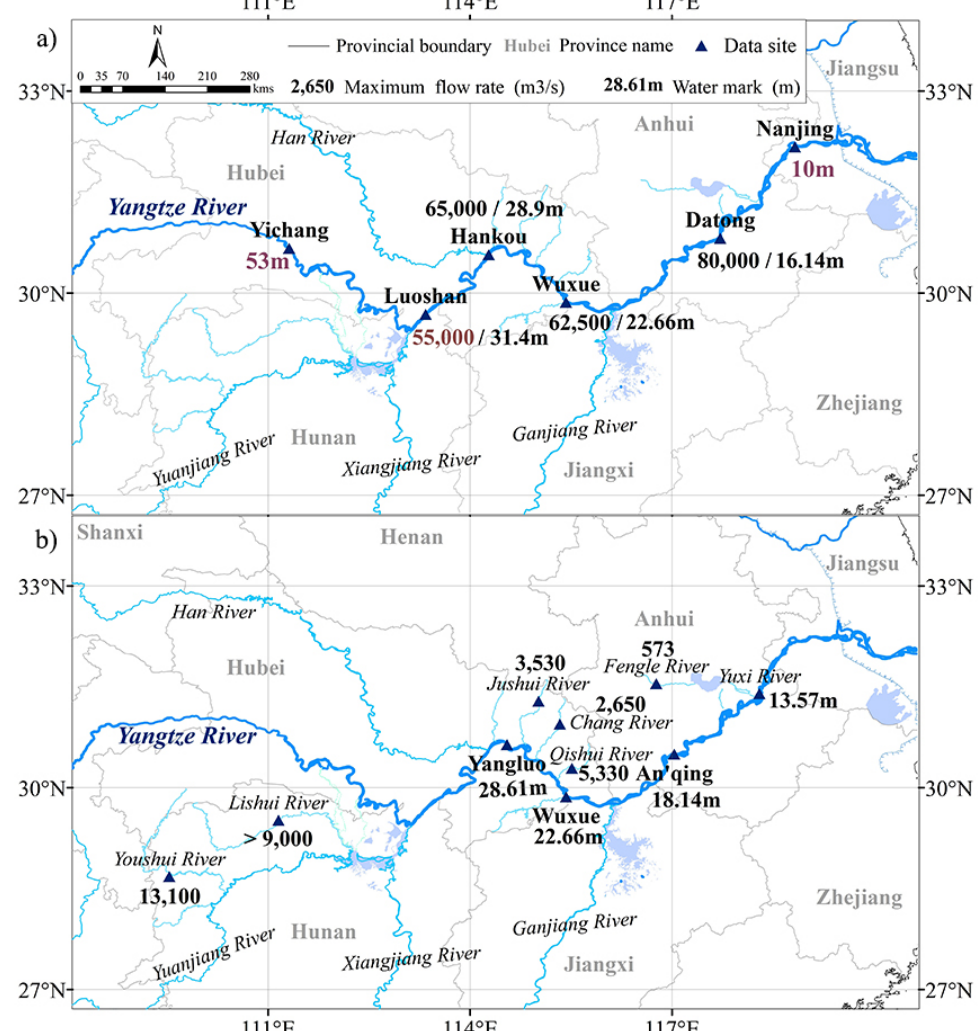
Figure 3. Flood peak flow rates and water levels of the Yangtze River in 1849. ( a ) shows the peak flow rates and water levels of the stations along the mainstream of the Yangtze River in 1849. Numbers such as “65,000” are the peak discharges of the year (m 3 /s), and numbers marked with “m” are the highest water levels of the year (relative to the base level at Wusong). The peak flow rate in black font is obtained by combining the peak water level/discharge curve of stations in 1954 [31]. The water level in black font is drawn based on the water level records extracted from “ The Compilation of Survey Data of Historical Great Floods in China ” [55]. The peak flow rates and water levels in purple font are drawn based on the comprehensive judgment of the peak water level/discharge curve of each station in 1954 and documented historical records. ( b ) shows the flood peak flow rates and water levels of the hydrological stations where the Yangtze River system reached the highest water level or flood flow rate in history in 1849, which is drawn according to “ The Compilation of Survey Data of Historical Great Floods in China ” [55].